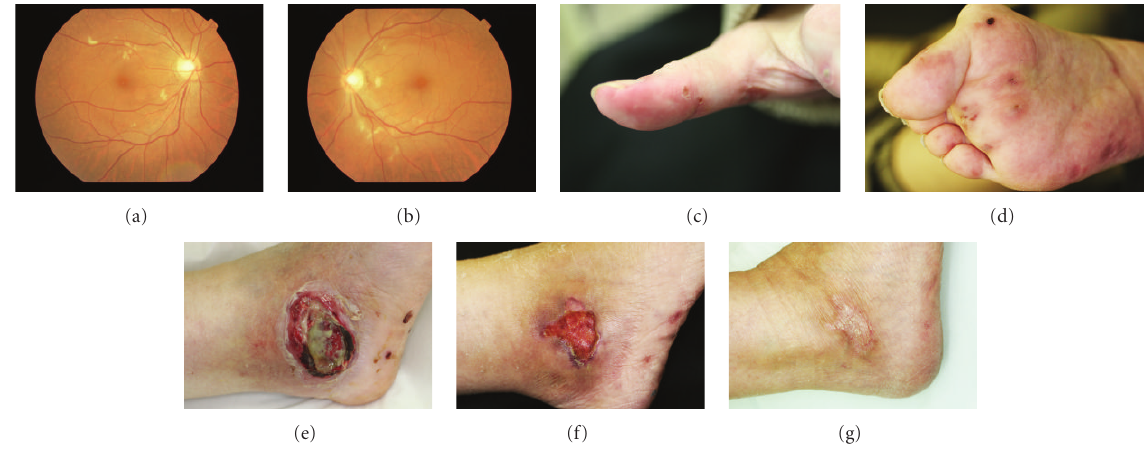
Figure 2: Four months after tocilizumab was discontinued and antibiotic therapy was started, (a, b) ocular findings and (c, d) rashes on the palm and planta pedis are improving gradually. The ulcerative infected skin lesions gradually resolved (e), (f), and (g). (e) Two days after debridement. The skin lesions resolved (f) 4 and (g) 9 months after discontinuation of